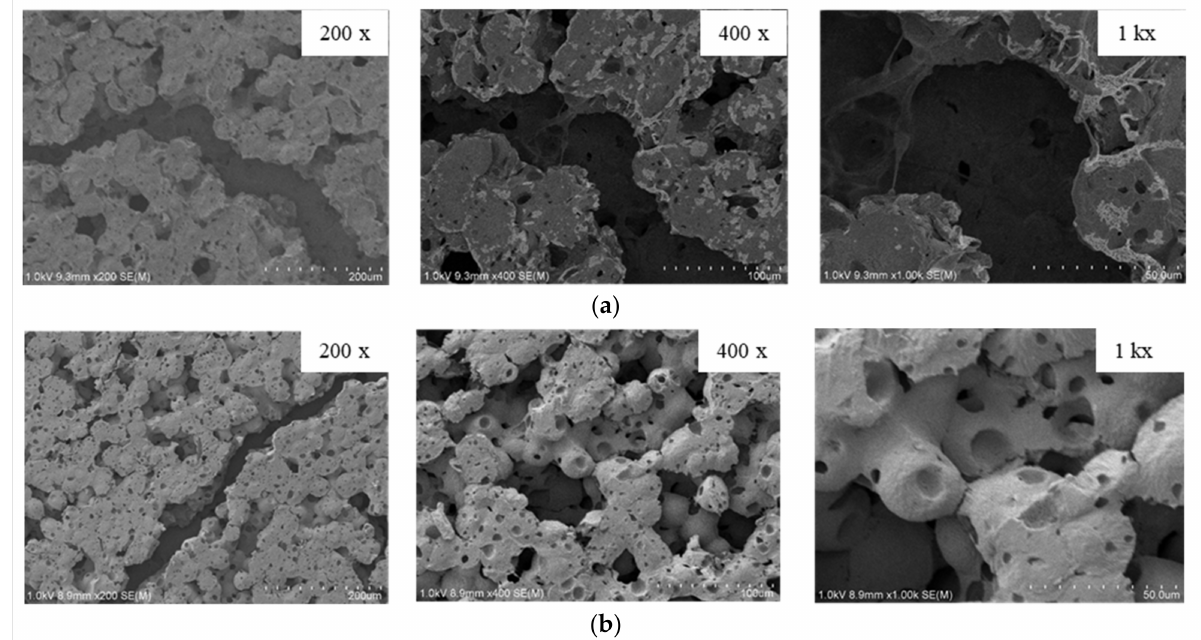
Figure 9. SEM morphology images of ( a ) non-crazed PLA/PAni film and ( b ) crazed PLA/PAni film after the biodegradation test. Table 3. The summarized characterization properties of non-crazed PLA/PAni and crazed PLA/PAni films.